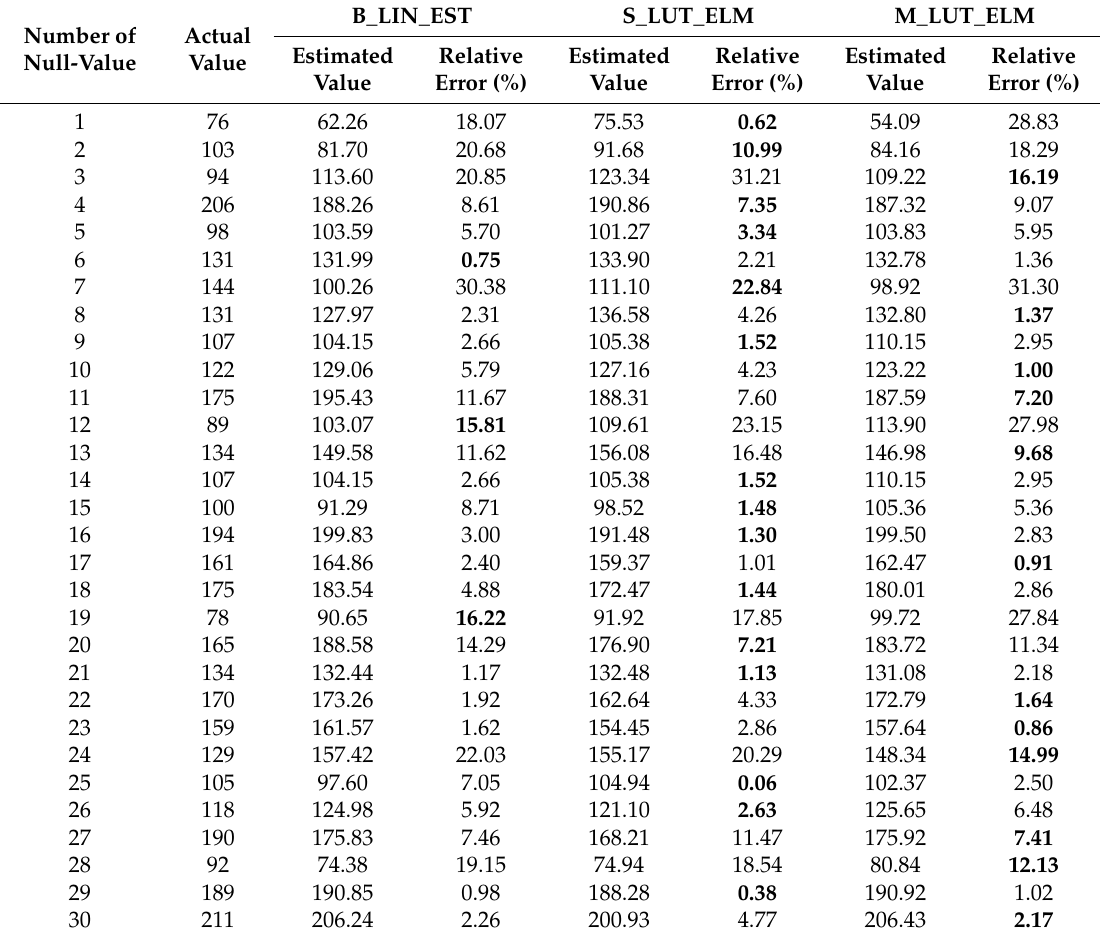
Table 2. Comparison of estimated values of null-value in